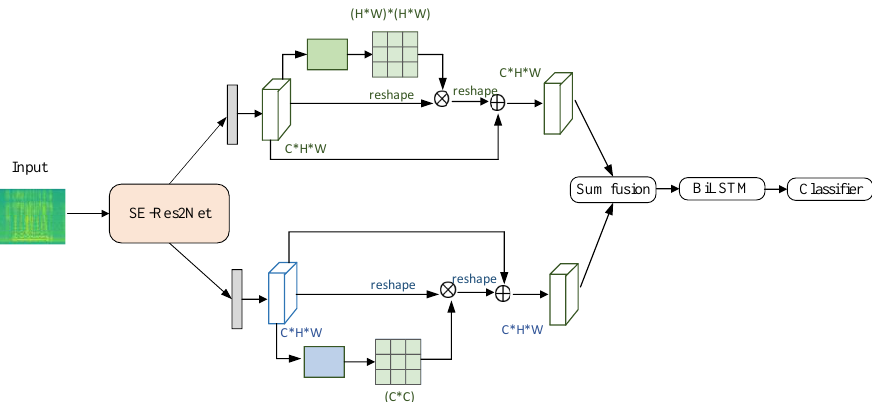
Figure 1. Block diagram of the SE-Res2Net-CBAM-BiLSTM language identification model structure.